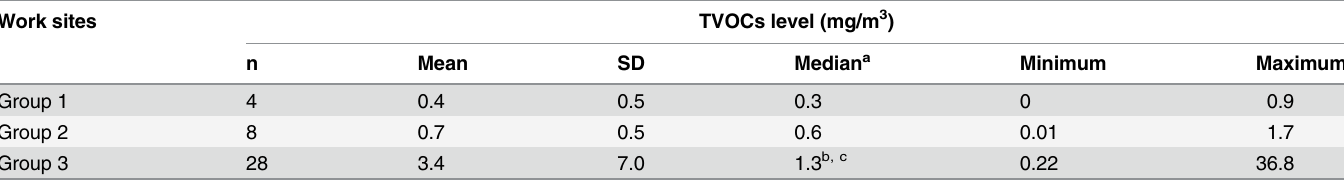
Table 3. Result of environmental TVOCs monitoring by worksites of different groups of MSWL workers.